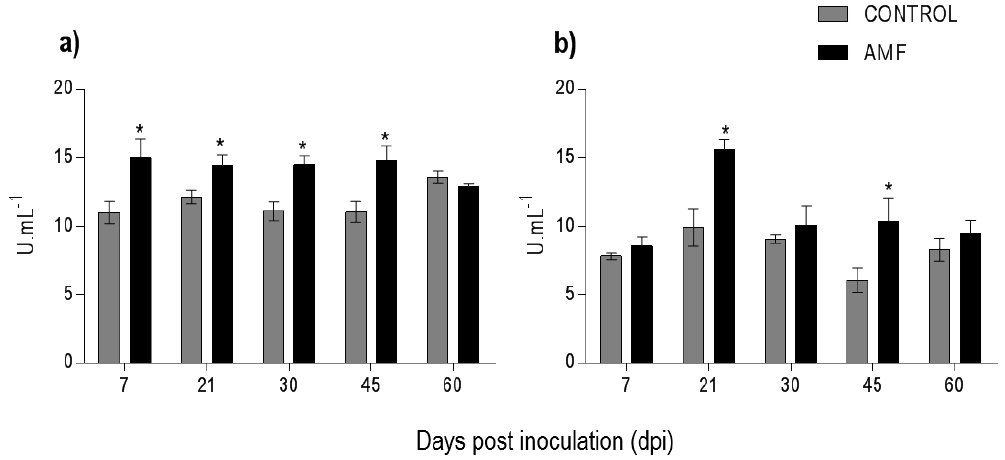
Figure 5. Activity of phenylalanine ammonia-lyase in Piper nigrum L. ( a ) leaves and ( b ) roots. Asterisks on the bars represent statistically significant differences between the treatment and control groups, at the 5% probability level, by Bonferroni.